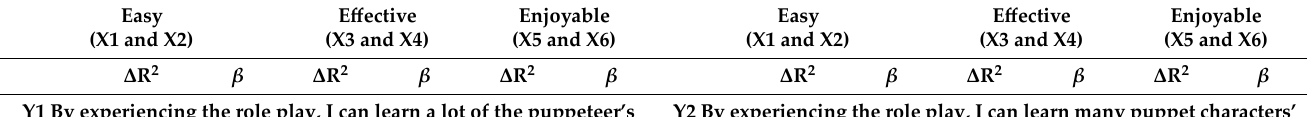
Table 12. The integrated Step 2 hierarchical regression analysis results with C1 through C3 as the control variables, one pair of (X1 and X2), (X3 and X4), and (X5 and X6) as the independent variables, and one of Y1 through Y6 as the dependent